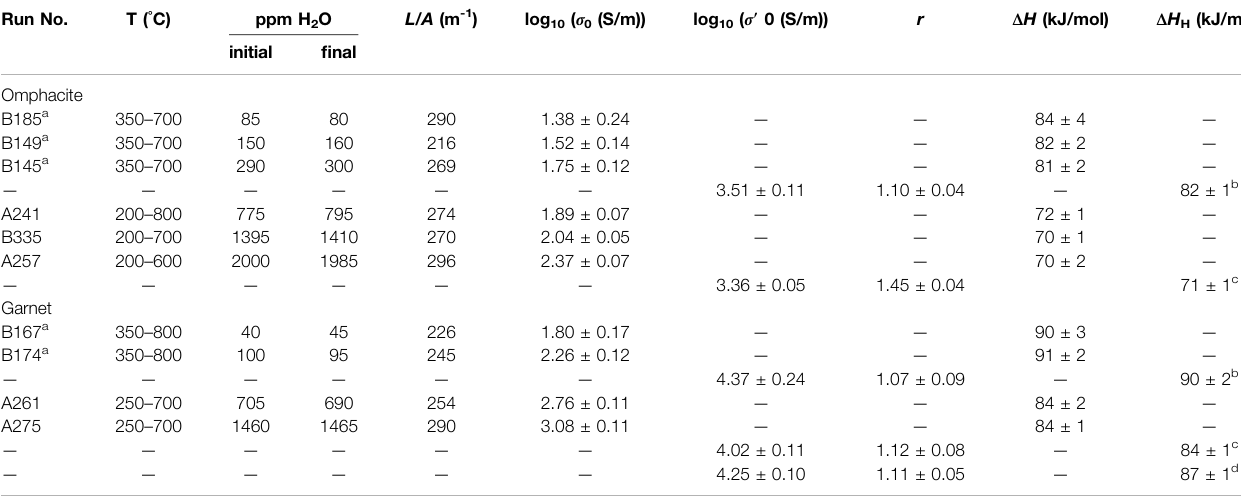
TABLE 2 | Summary of samples and fi tting parameters in conductivity runs. Run No.